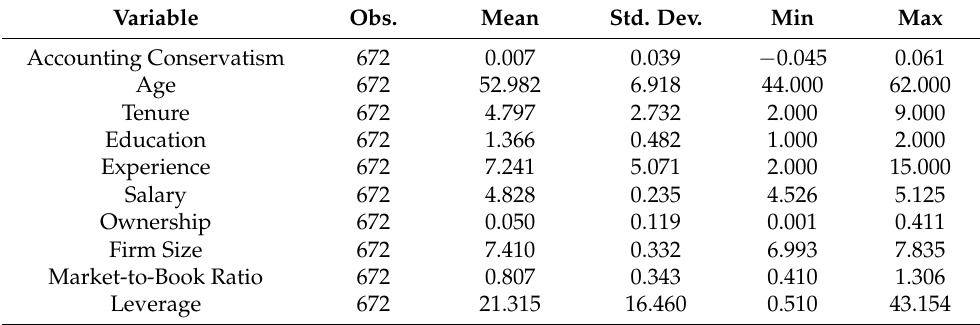
Table 2. Descriptive statistics of research